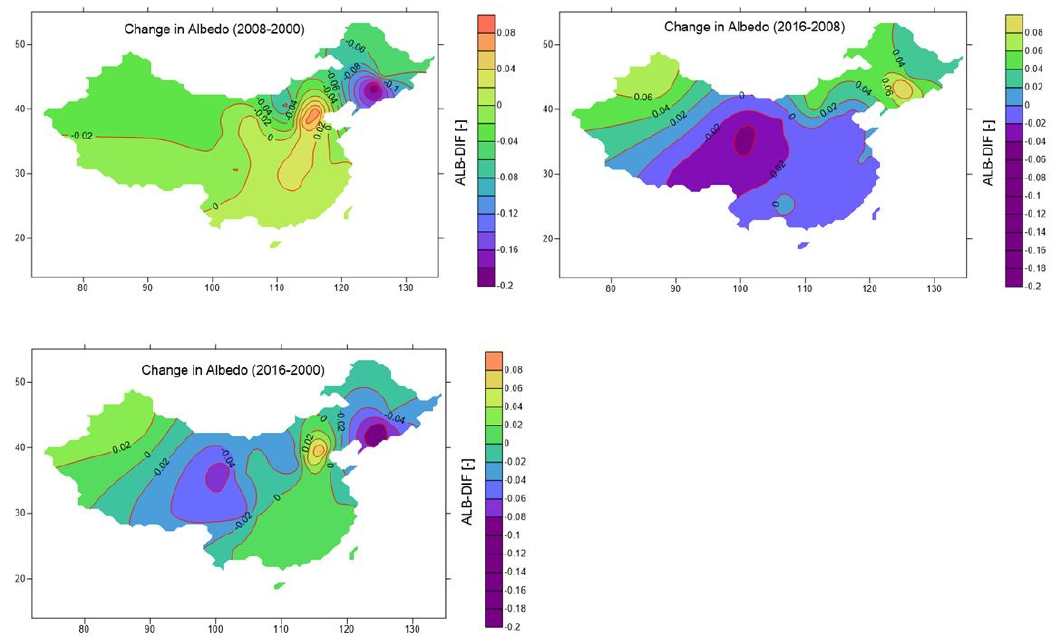
Figure 6. Surface albedo variations from 2000 to 2016.